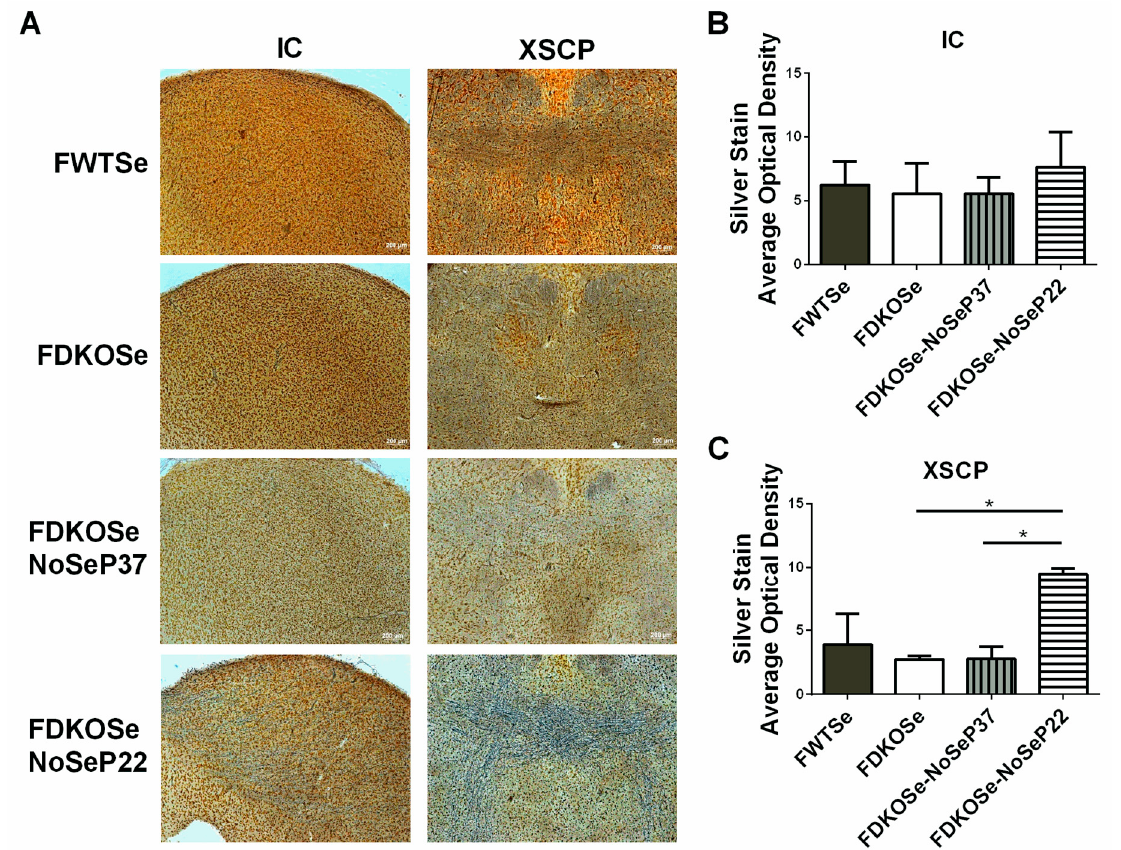
Figure 4. E ff ect of SeH 2 O (supplemental Se water) withdrawal age on silver staining in female double knockout mice supplemented with Se (FDKOSe). ( A ) Representative images of silver staining in inferior colliculus (IC) and the decussation of the superior cerebellar peduncle (XSCP) of female wild-type mice supplemented with Se (FWTSe), FDKOSe, FDKOSe-NoSeP37 (supplemental Se removed at P37), and FDKOSe-NoSeP22 mice at 10 weeks of age. Quantification of average optical density in ( B ) IC and ( C ) XSCP. (one-way ANOVA IC NS, XSCP p = 0.0187; Bonferroni’s multiple comparisons test: * p < 0.5; n = 3 all groups). All values reported as mean ± SEM.